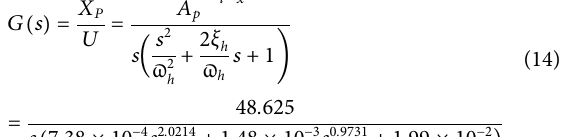
GA − FOPID controller, integer order GA − PID controller, fractional order PSO − FOPID controller, integer order PSO − PID controller, and integer order WOA − FD controller. In this study, the intelligent optimized whale algorithm WOA is directly applied to the systematic controllers of the oil cylinder DOA 090470 − 1 ( 1 ) and DOA 090260 − 1 in the manipulator for parameter tuning, and the control strategies of different combinations are compared and analyzed (Table 4).